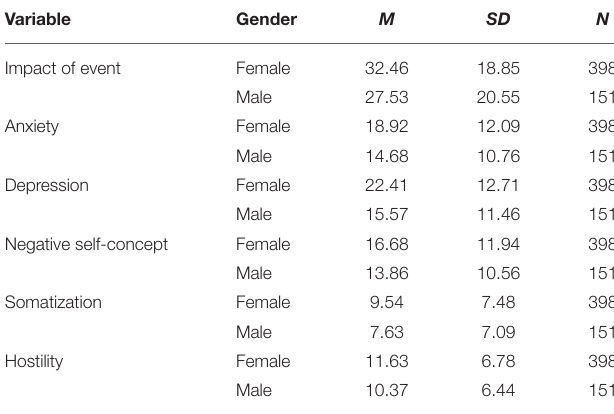
TABLE 2 | Descriptive statistics for male and female